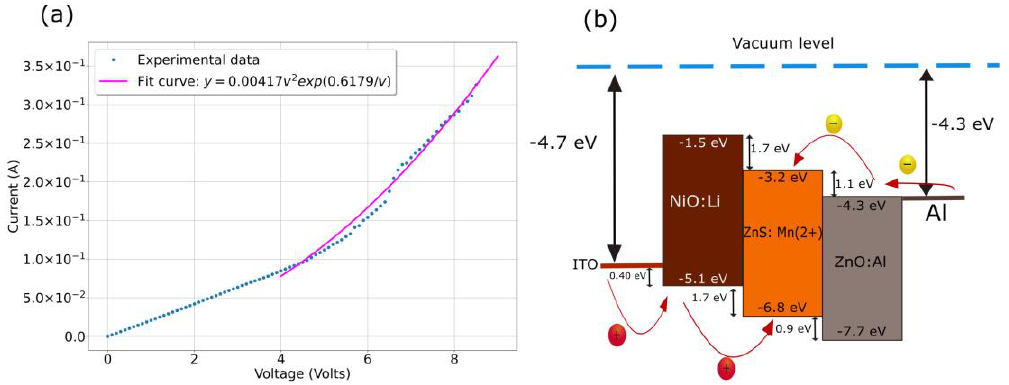
strate. ( a ) SEM image. ( b ) Cross section SEM micrograph. ( c ) XRD pattern, it shows a cubic structure